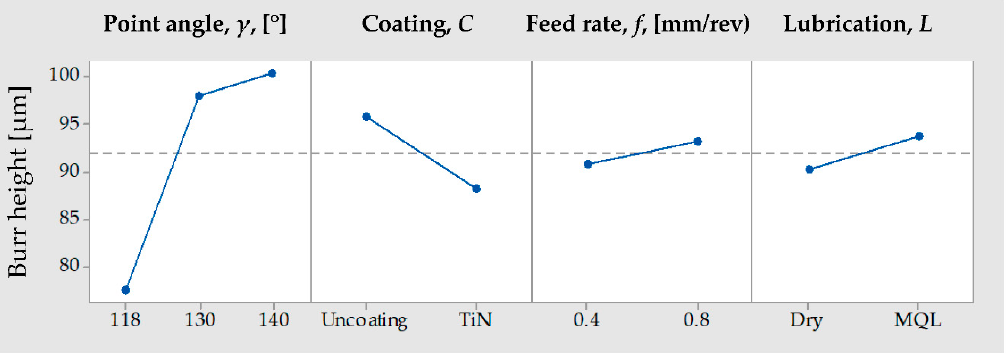
Figure 13. Main effects plot for burr height mean values. Figure 13. Main e ff ects plot for burr height mean values.